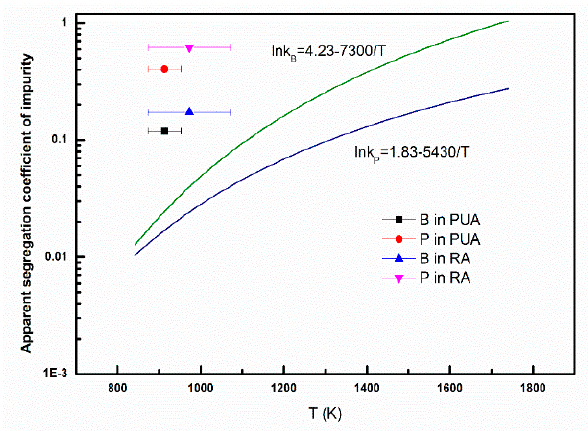
Figure 6. Relationship between apparent segregation coe ffi cients of B, P vs. temperature.